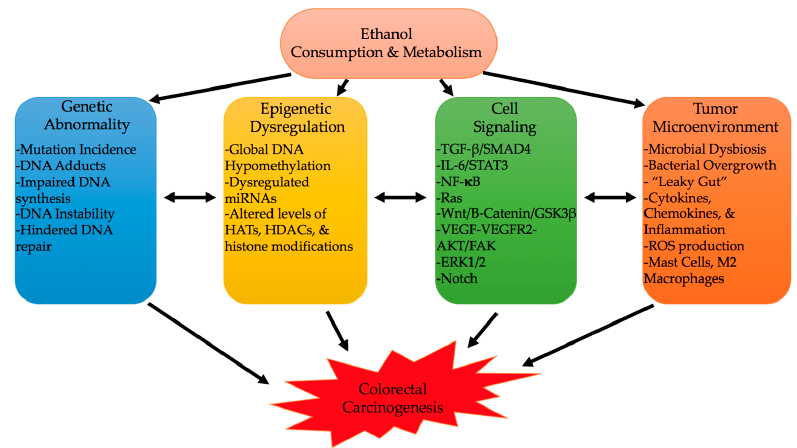
Figure 3. Genetic abnormality, epigenetic dysregulation, cell signaling, and the tumor microenvironment are the hallmark effects that ethanol produces to instigate colorectal carcinogenesis. These hallmark mechanisms interact and lead into each other to further increase the carcinogenic state.